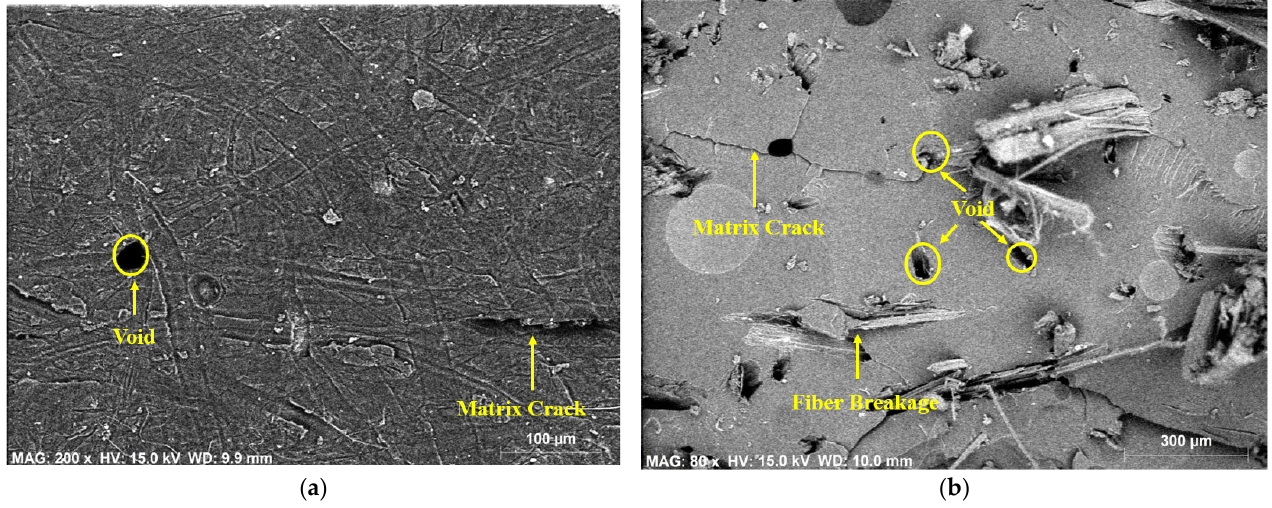
Figure 6. SEM EDX analysis on hemp-fiber-reinforced epoxy composite at surface ( a ) and fracture ( b ) positions.